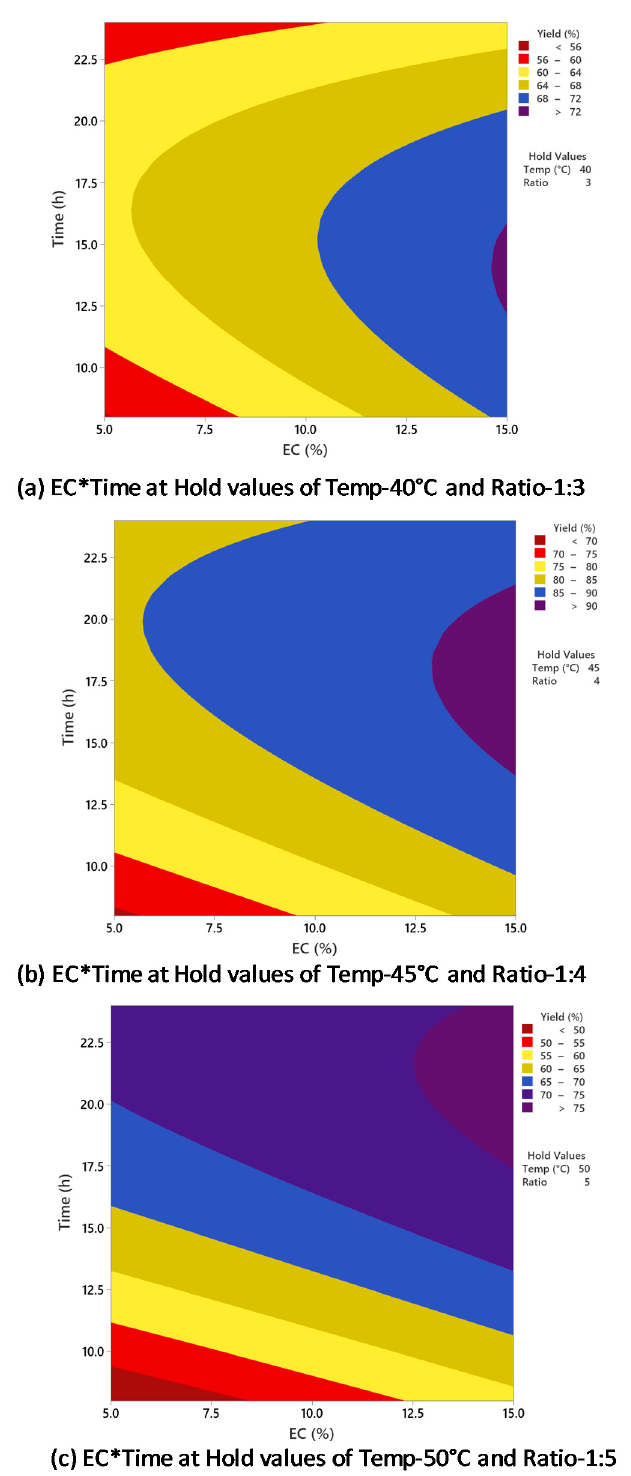
Figure 6. Counterplots of biodiesel yield vs. enzyme concentration and time at ( a ) 40 ° C and 1:3; ( b ) 45 ° C and 1:4; ( c ) 50 ° C and 1:5.